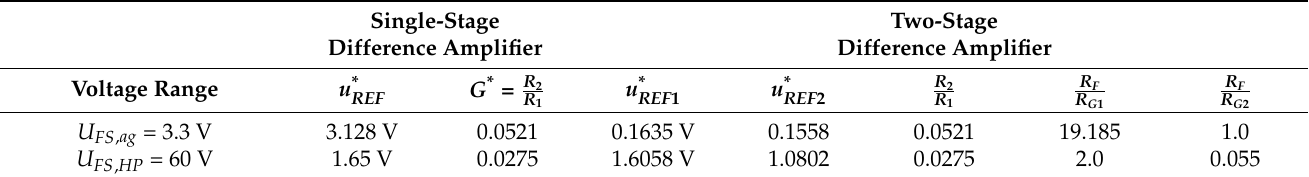
Figure 6. Designation of measured voltages in respect to gnd (in blue) and output voltage referenced to GND (in grey) (not in scale). Table 1. Comparison between single- and two-stage difference amplifiers’ setpoints.